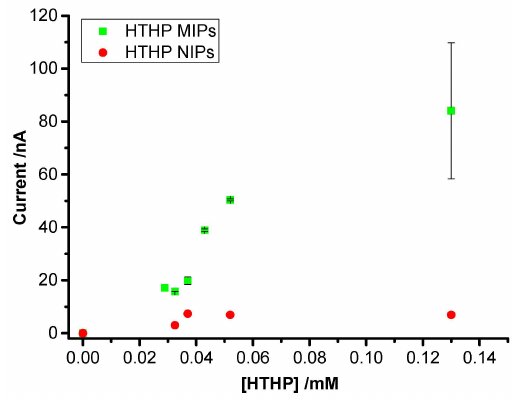
Figure 4. SWV peak currents for MIP- and NIP-modified electrodes after incubation in 2.5 mM K 2 HPO 4 –KH 2 PO 4 pH 7 and different HTHP concentrations. Table 1. Examples of protein MIPs prepared by